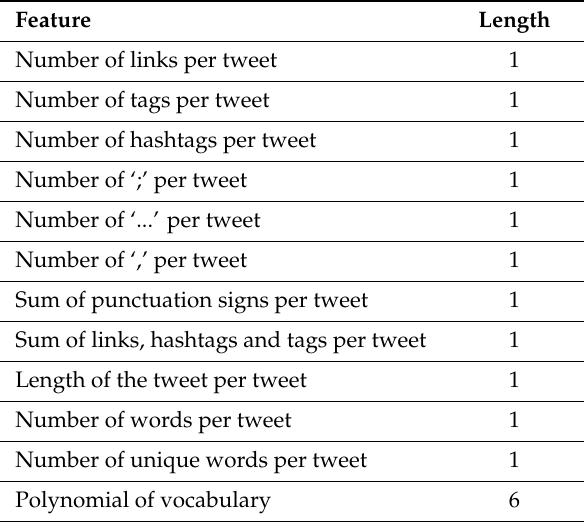
Table 2. Textual features extracted from user tweets for DBT